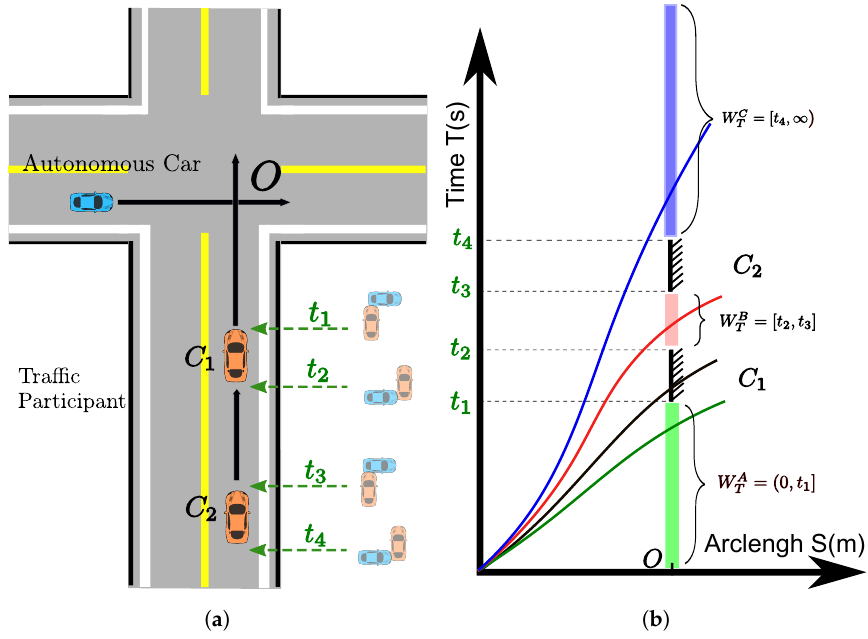
Figure 4. A cross scenario with moving vehicles. ( a ) A cross scenario without traffic lights. The blue car is the autonomous car. The orange cars ( C 1 , C 2 ) are the oncoming vehicles with prescribed speed profiles. ( b ) A S-T graph that describes different types of time windows and possible solutions to avoid moving vehicles. The S is the arc-length along the path of the autonomous